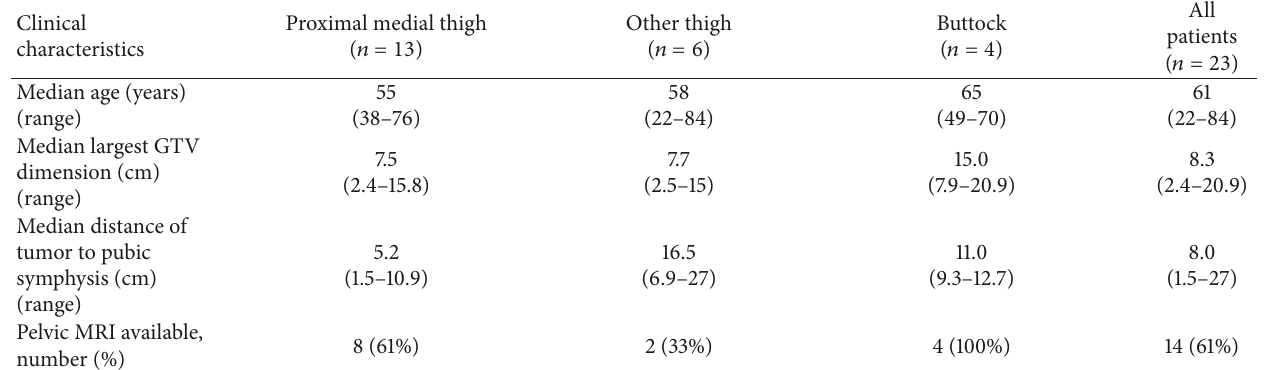
Table 1: Patient characteristics ( 𝑛 = 23